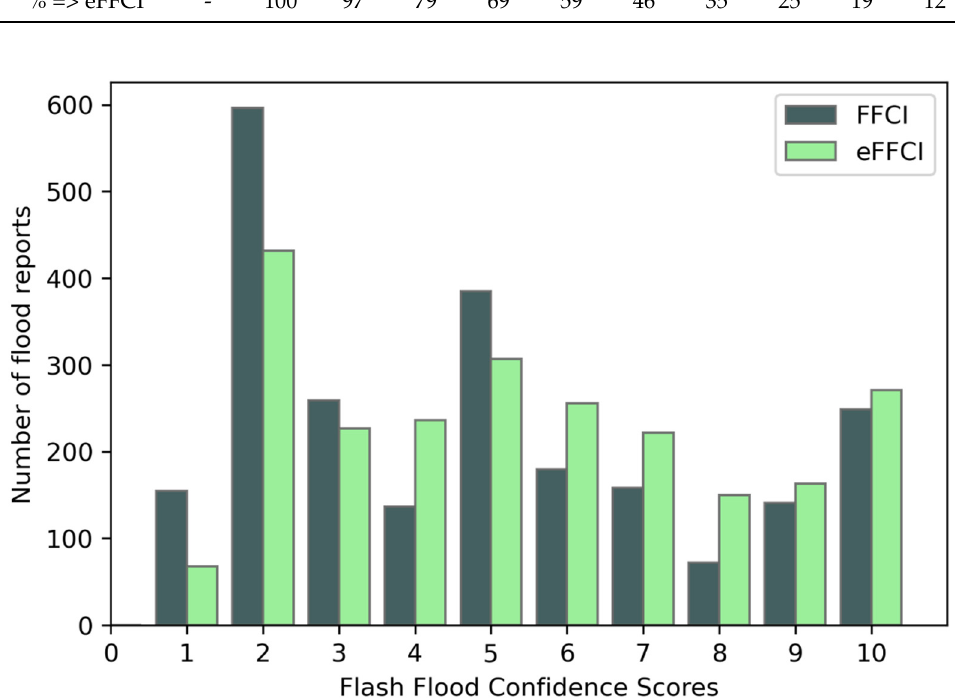
Figure 5. Distribution of FFCI and eFFCI applied to 2332 potential flash flood